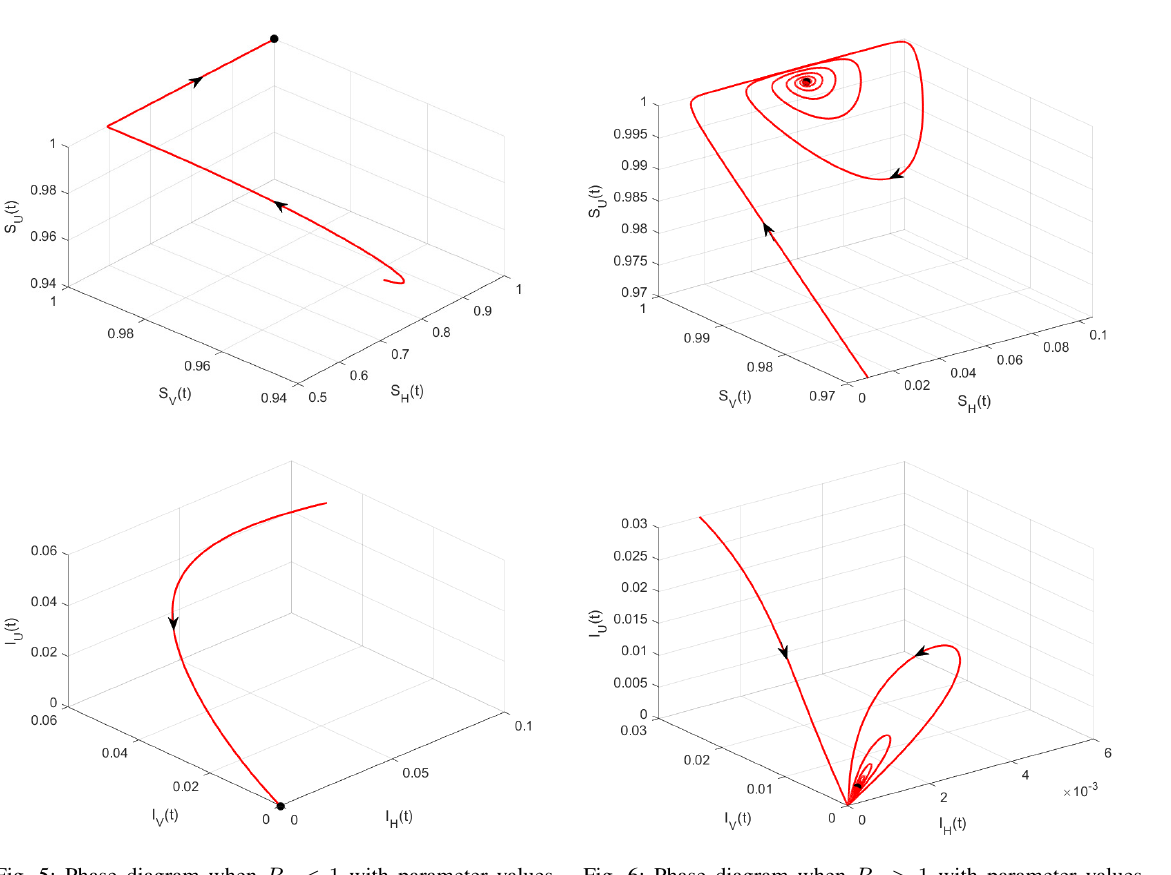
Fig. 5: Phase diagram when R 0 < 1 with parameter values taken to be α 1 = 2 , α 2 = 3 , κ 1 = 0 . 3 , κ 2 = 0 . 2 , ε 1 = 0 . 67 , ε 2 = 0 . 06 , ε 3 = 0 . 06 , µ H = 0 . 00004 , µ V = 0 . 07 , µ U = 0 . 07 , β 1 = 0 . 3 , β 2 = 0 . 3 , λ = 0 . 01 , γ = 0 . 16 , θ 1 = 0 . 2 , θ 2 = 0 . 3 .